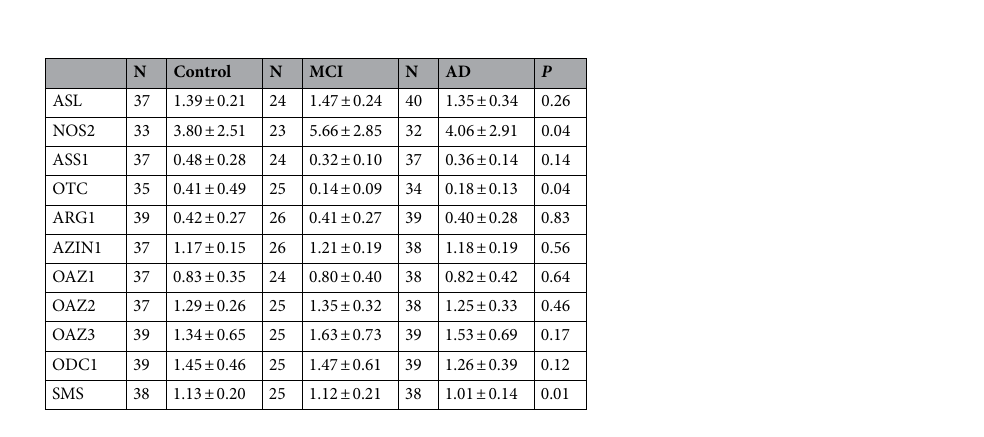
Table 4. Relative mRNA expression levels of metabolism enzymes.